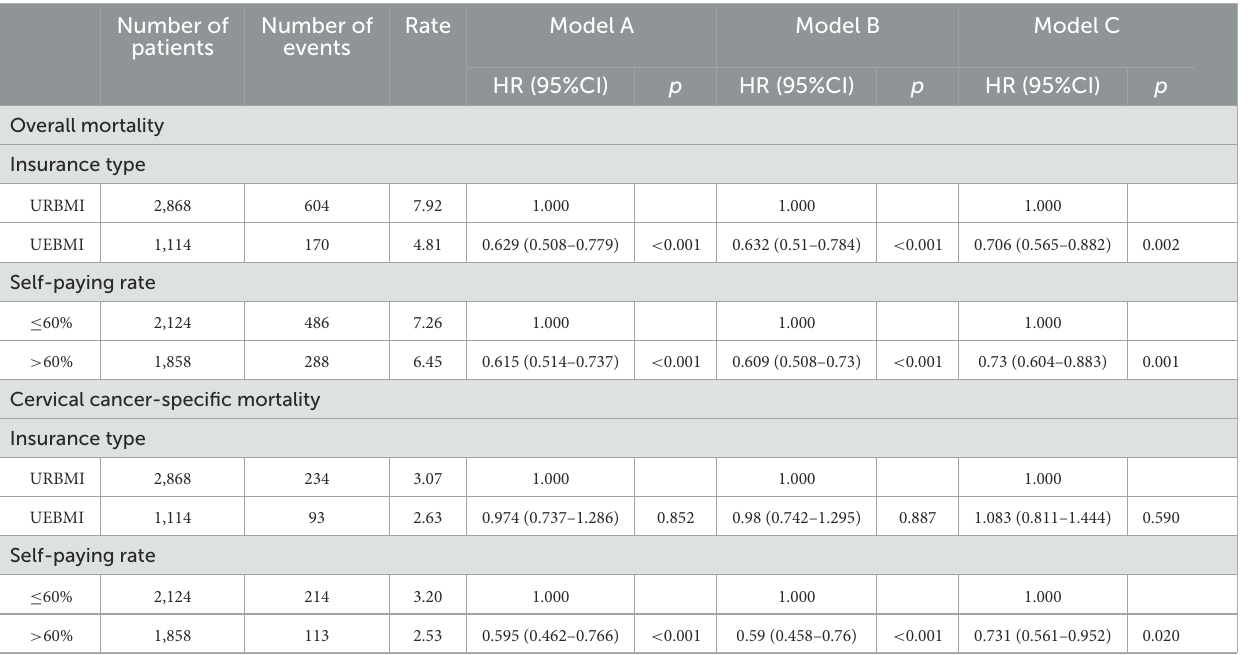
TABLE 4 Associations of insurance type and self-paying rate with cervical cancer-specific mortality and all-cause